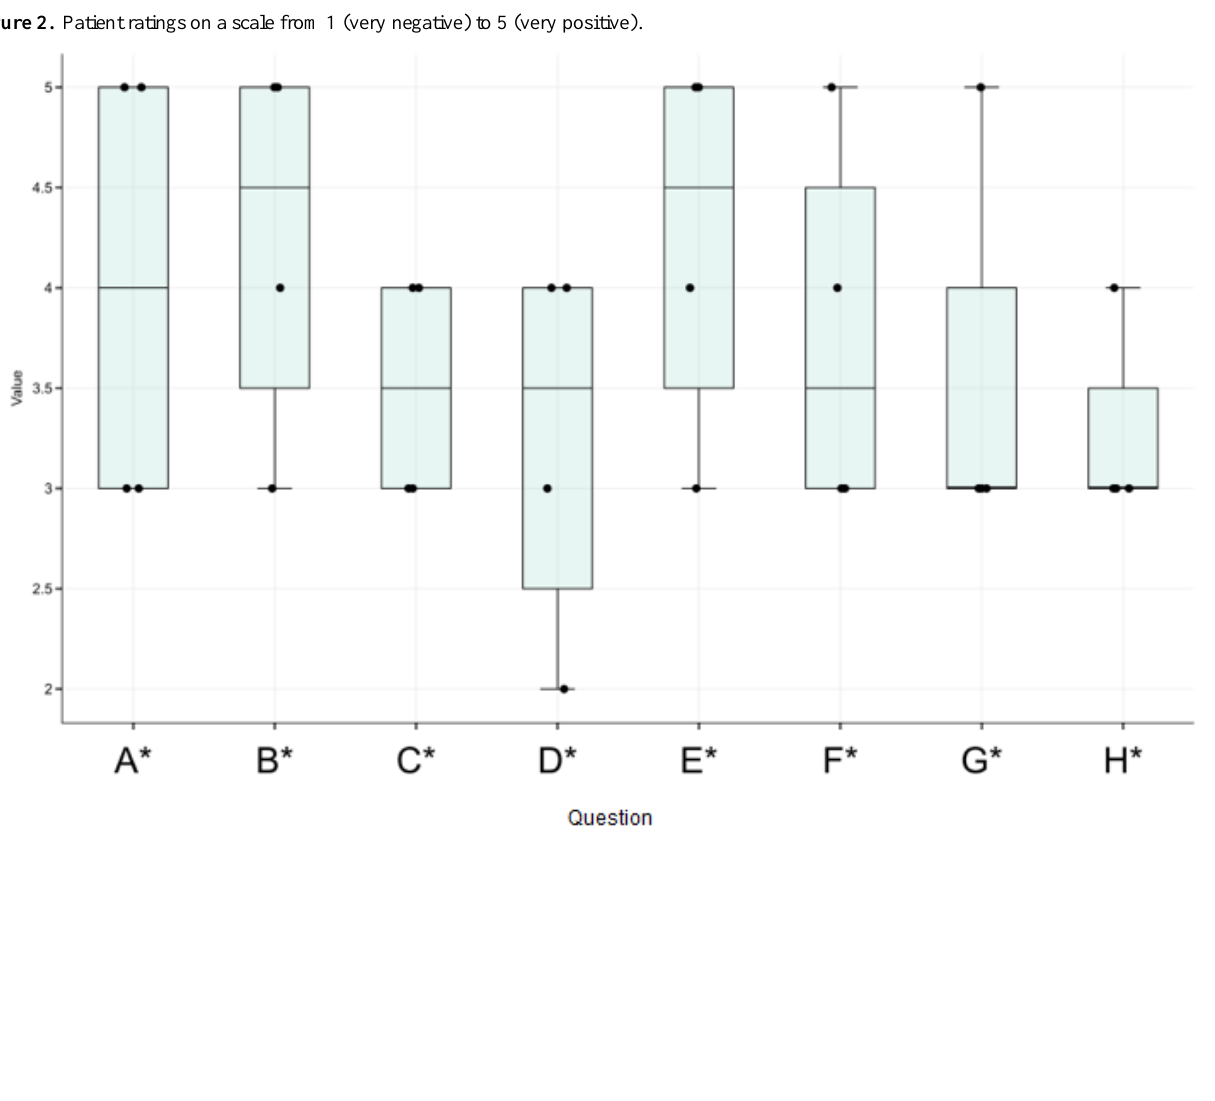
Figure 2. Patient ratings on a scale from 1 (very negative) to 5 (very